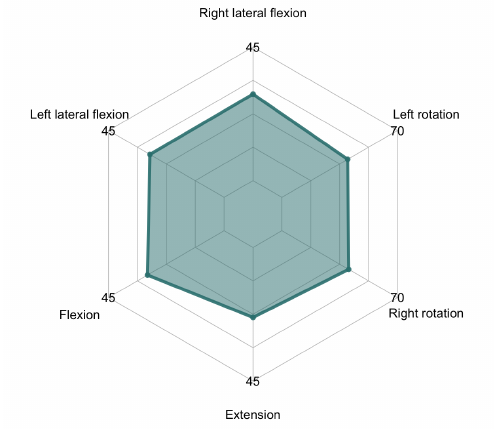
Figure 6. Mean values of the neck range of motion (ROM) tracked by the head-tracker interface compared to normal maximum